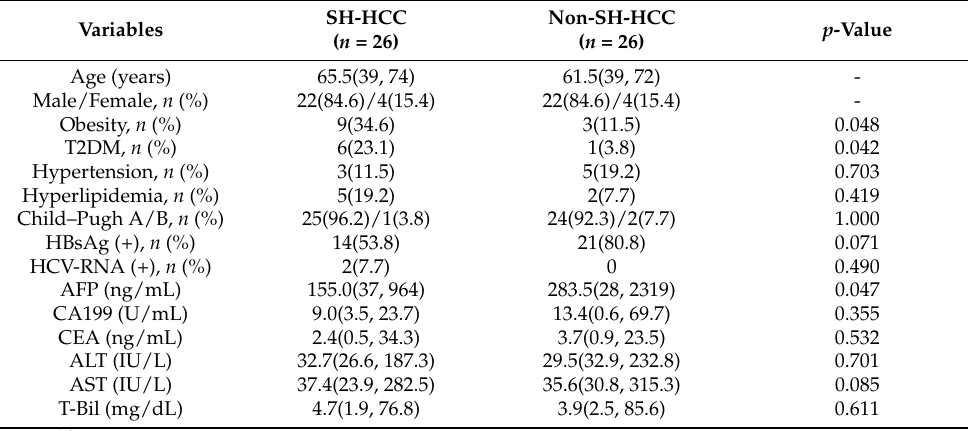
Table 1. Baseline characteristics of SH-HCC and non-SH-HCC patients.